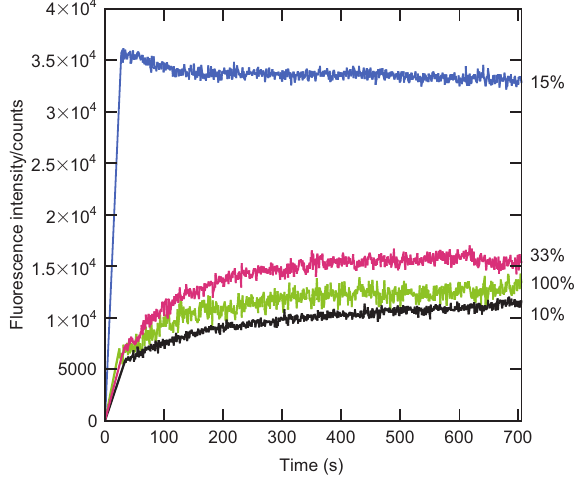
Figure 14 Infl uence of the concentration of acid-anchoring groups on the change of fl uorescence intensity during hybridization of 5 n m com- plementary DNA targets in PBS with DNA probes immobilized from a 0.5 μ m solution. Concentration of anchoring groups in the molecular layer: 100 % (green); 33 % (red); 15 % (blue) and 10 %